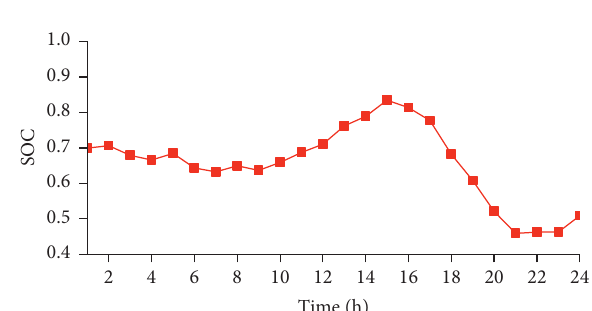
Figure 12: SOC of storage battery for scheme 2.